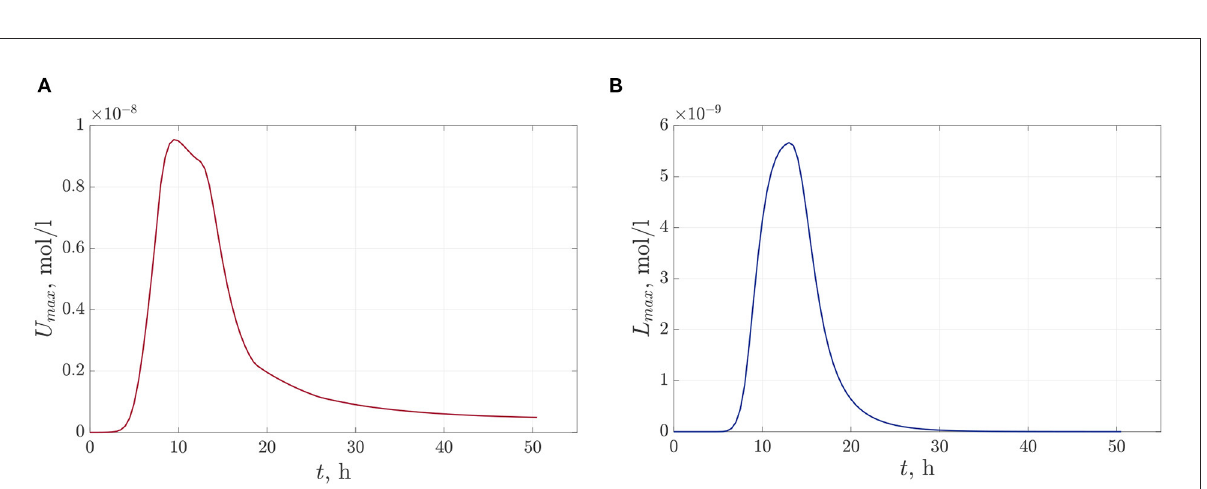
FIGURE7 The time-dependent profiles of maximum values of chemical compounds during the observation time 50 h: (A) —the AHL concentration and (B) —the Lactonase concentration at single antibiotic treatment.